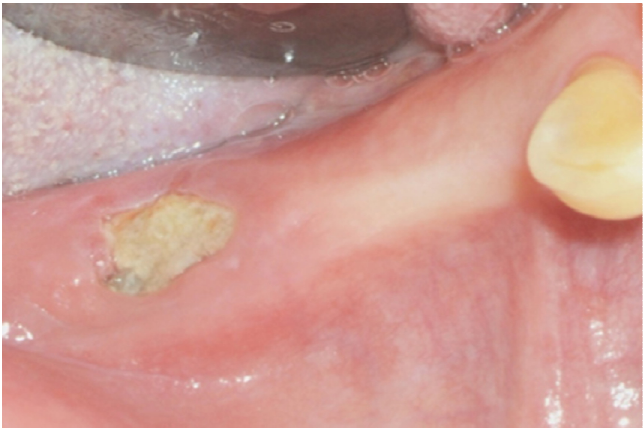
Figure 2. Intraoral image of the original situation of an osteonectotic lesion of the IV quadrant.